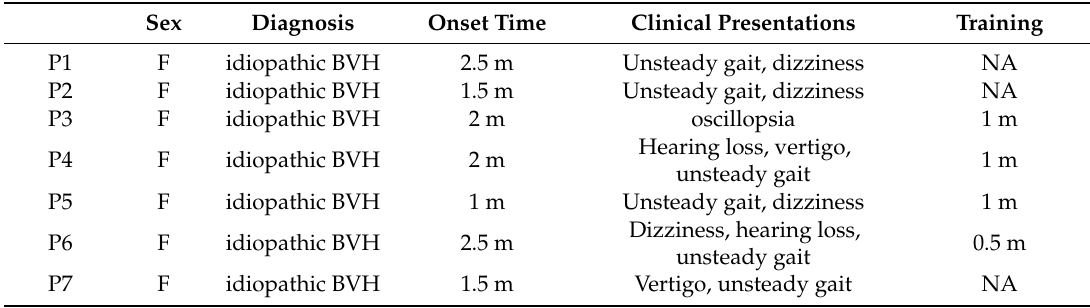
Table 1. Demographic data for patients with bilateral vestibular hypofunction